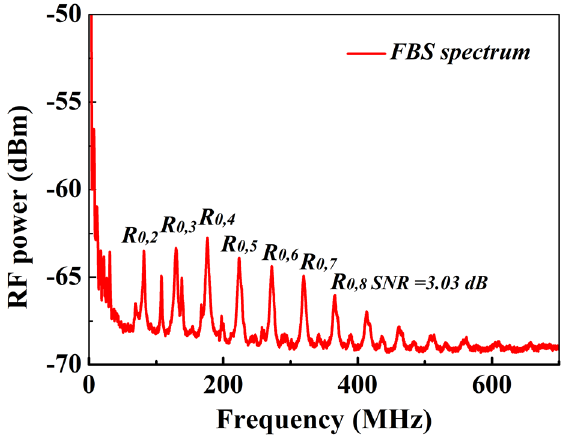
Figure 6. The measured FBS spectrum (FBSS) in the MSI 2-LP-mode fiber. Furthermore, compared with the BGS in the MSI 2-LP-mode fiber, the FBS process involves multiple acoustic modes, and the FBSS shows a multi-peak shape. These